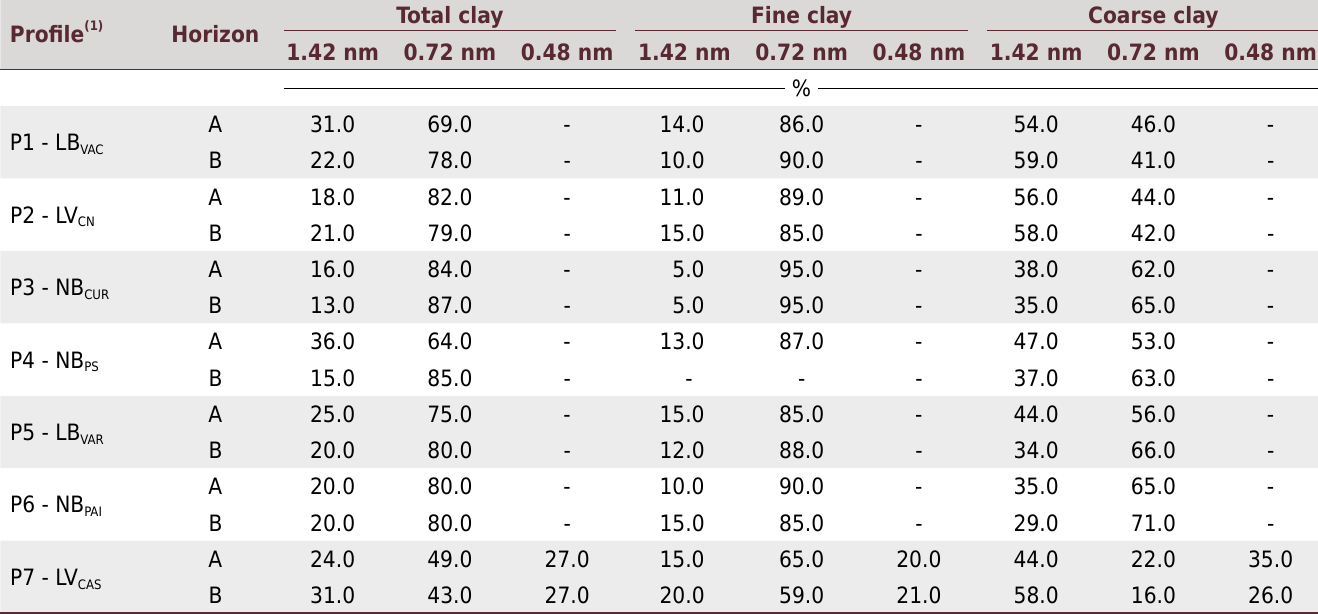
Table 2. Values related to the percentages of each mineral in the clay fraction, calculated by HighScore Plus software and obtained from estimates of the peak areas in the respective peak positions (1.42 nm, 0.72 nm, and 0.48 nm) for total, fine, and coarse clay fractions Profile (1)